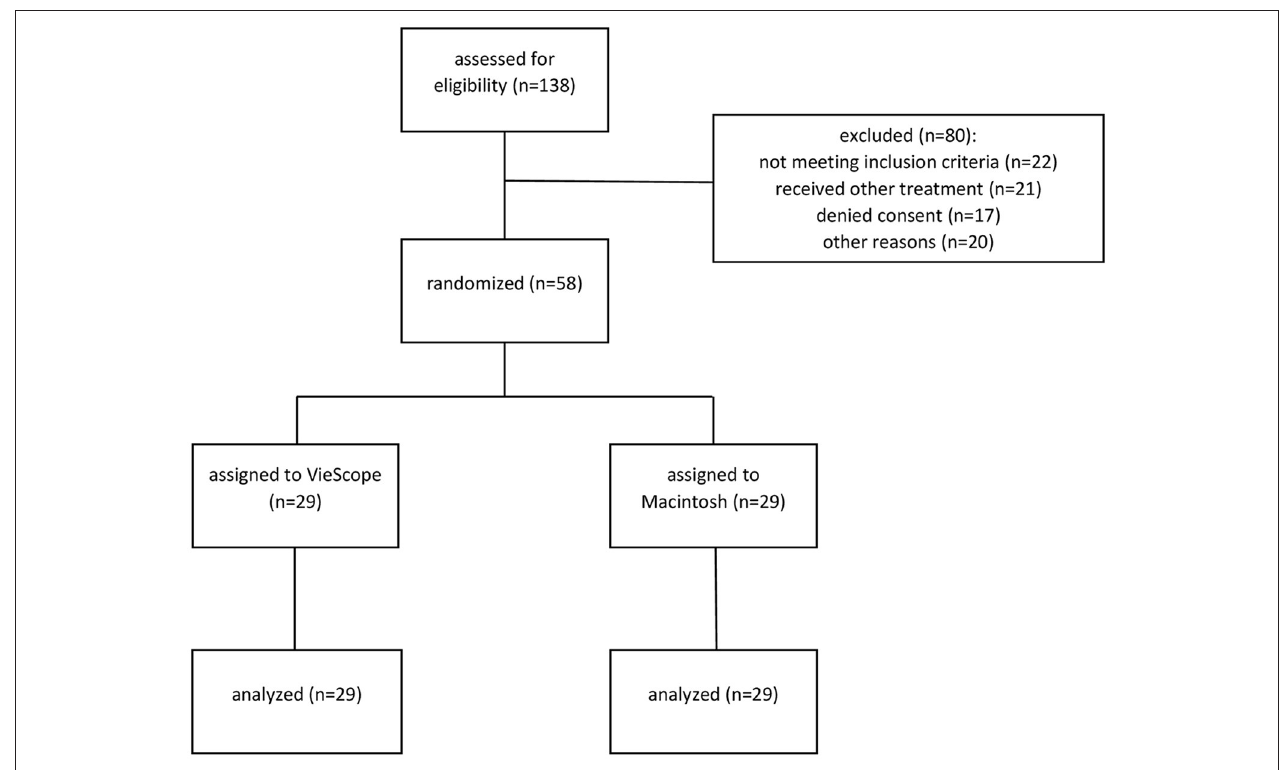
FIGURE 1 | Consolidated standards of reporting (CONSORT)